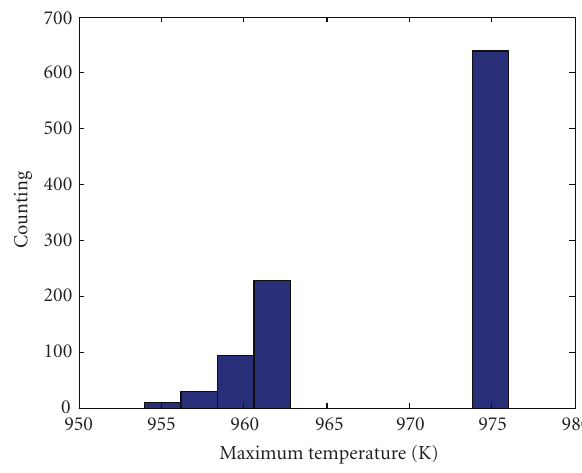
Figure 5: Histogram of the B = 1000 bootstrap estimates of the 95th percentile for N =